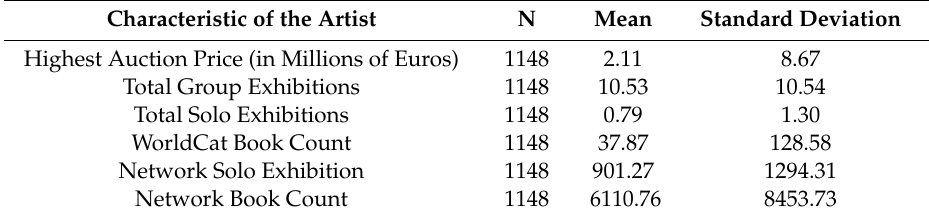
Table 1. Calculations regarding the study population of